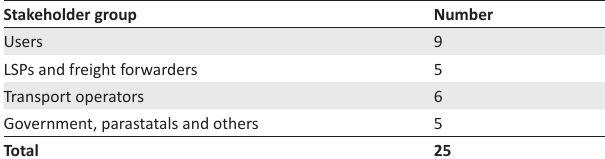
TABLE 1: Number of interviews per stakeholder